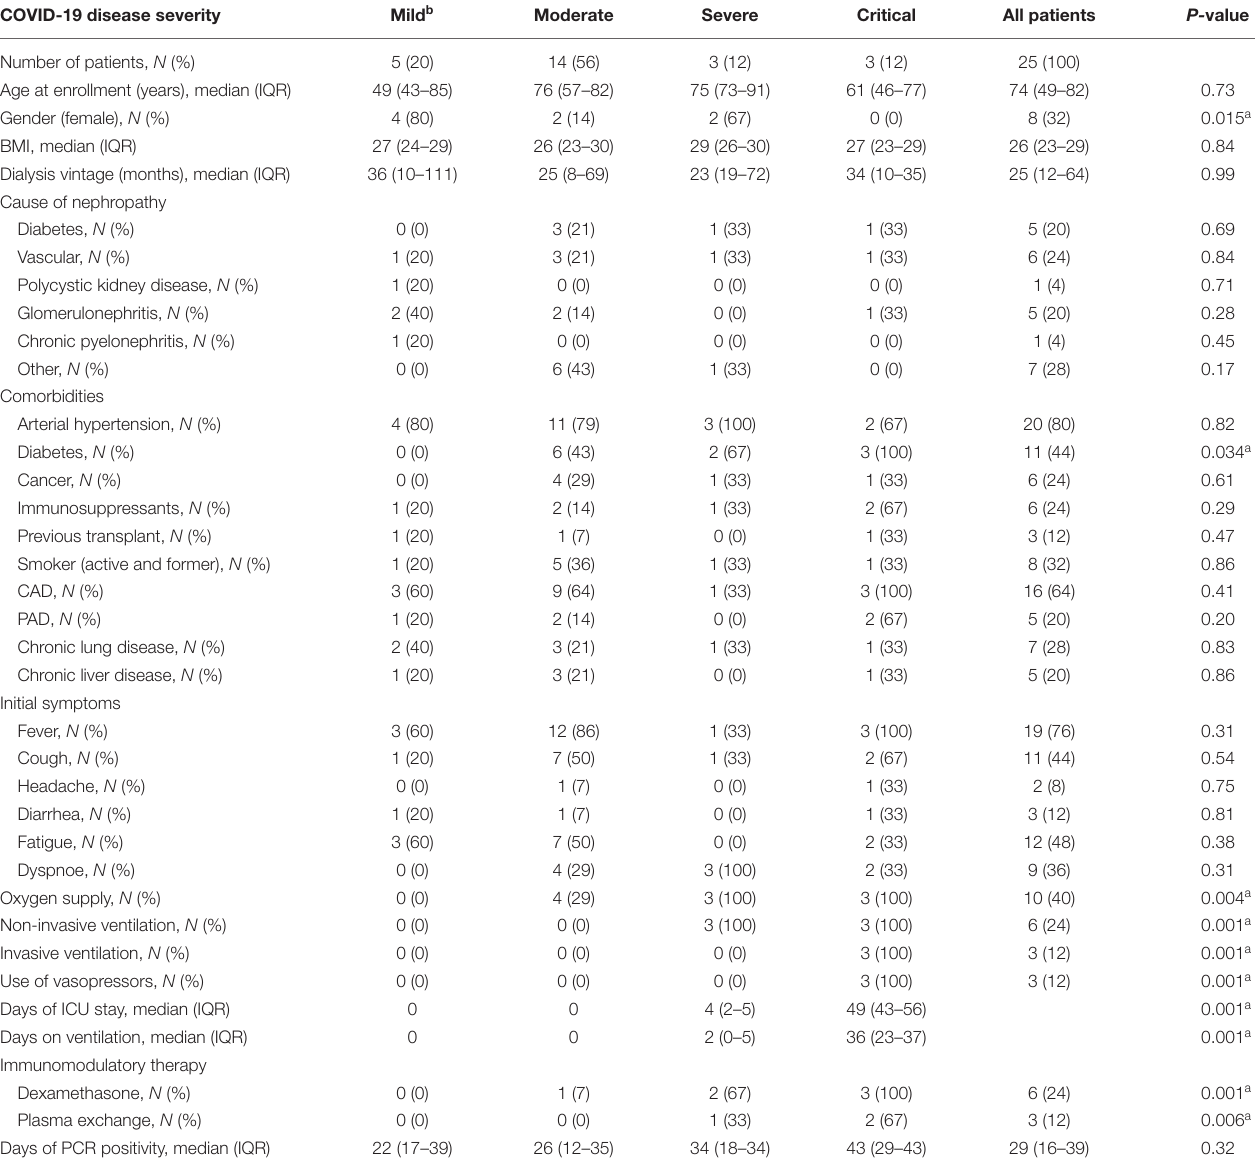
TABLE 2 | Clinical characteristics and COVID-19 disease courses of dialysis patients with COVID-19 infection. COVID-19 disease severity Mild b Moderate Severe Critical All patients P-